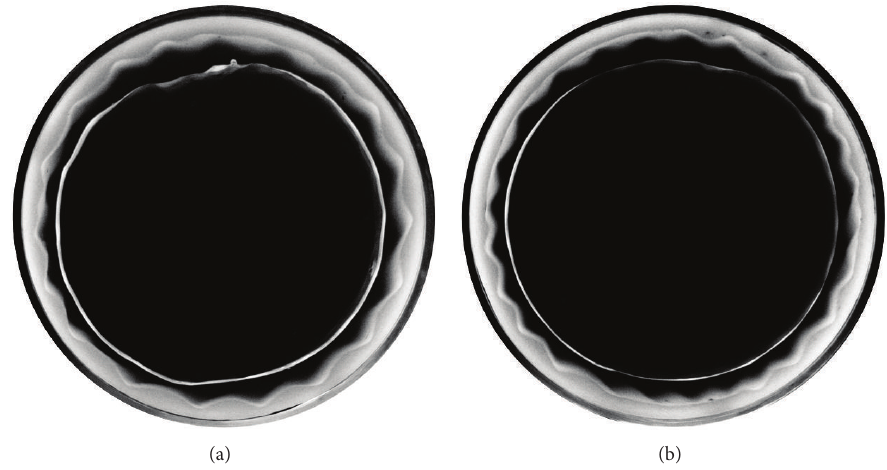
Figure 4: The sinusoidal ripples at Ω = 33.9 s −1 (a) and 37.7 s −1 (b), 𝑞 = 0.257 , ] = 1.4 cSt, and 𝑚 = 250